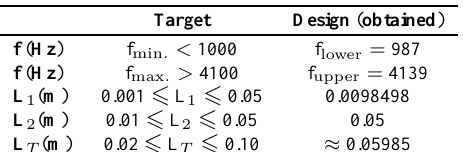
Table 3 Target and design values for example 3